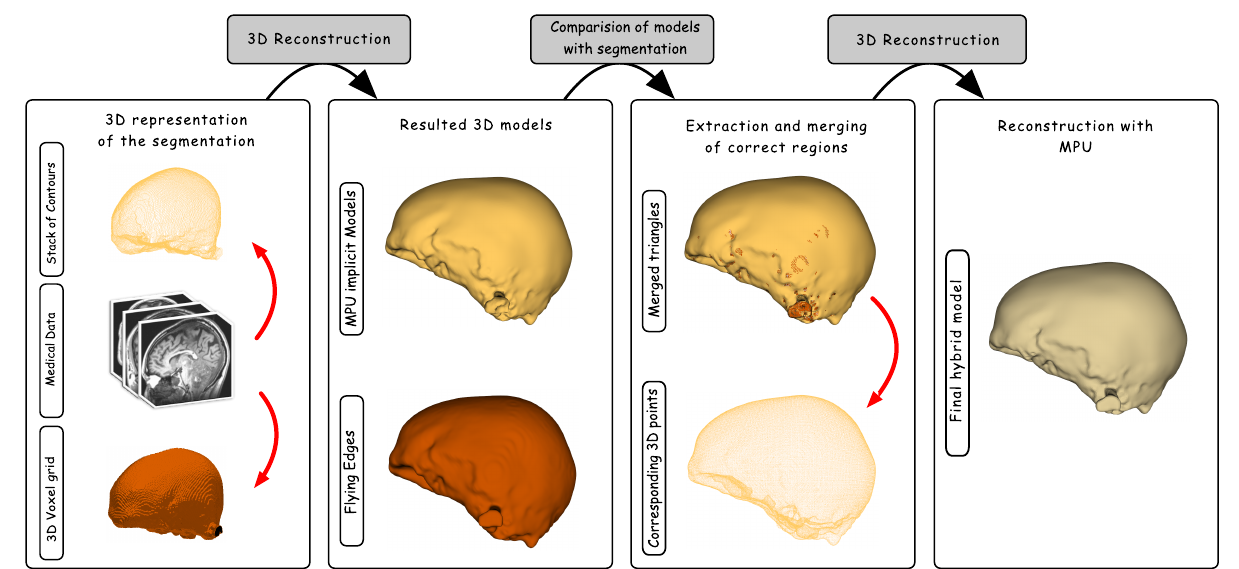
Figure 4. The pipeline of our hybrid reconstruction system: two reconstructed 3D models based on FE and MPU are generated. The resulted models are compared with the segmentation and the correct regions are extracted and merged. The MPU is fit to the points extracted from the merged triangles to produce the 3D geometric